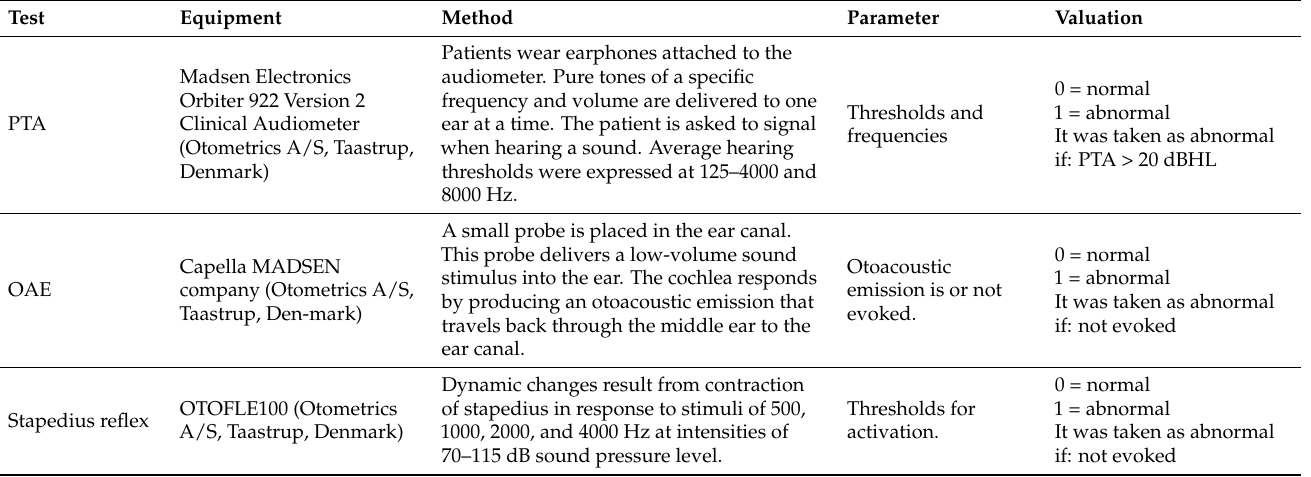
Table 1. Methodology and parameters of the